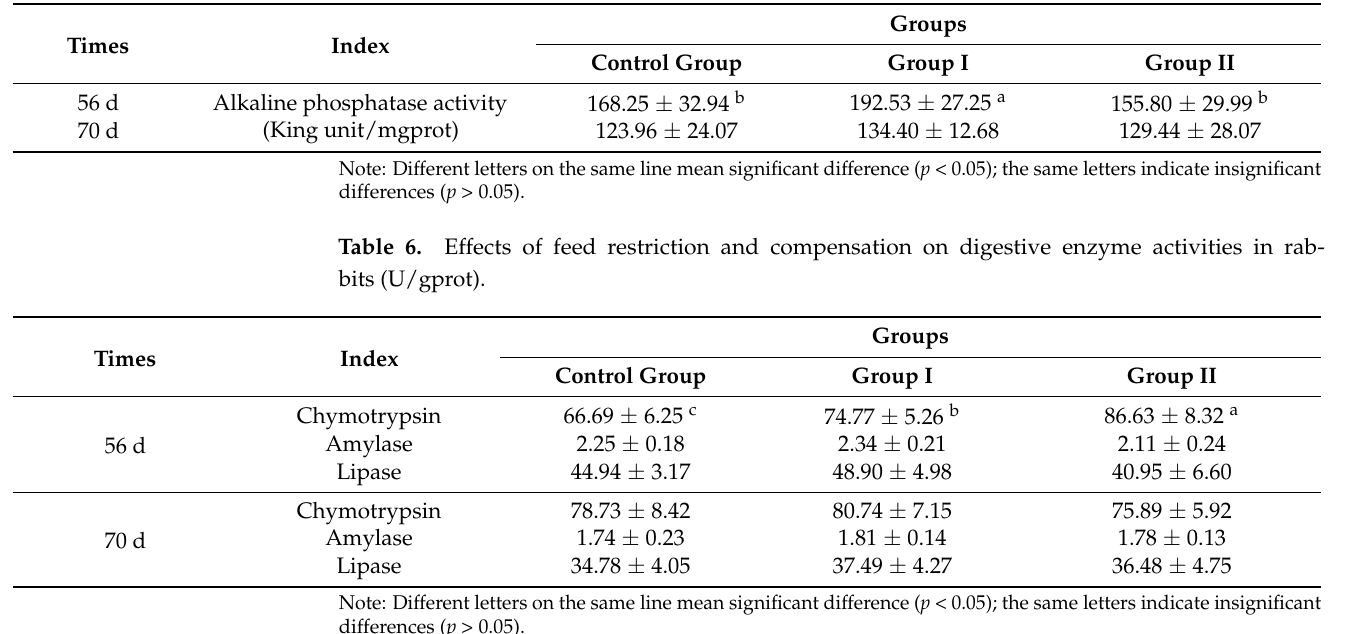
Table 5. Effects of feed restriction and compensation on alkaline phosphatase activity in rabbits.